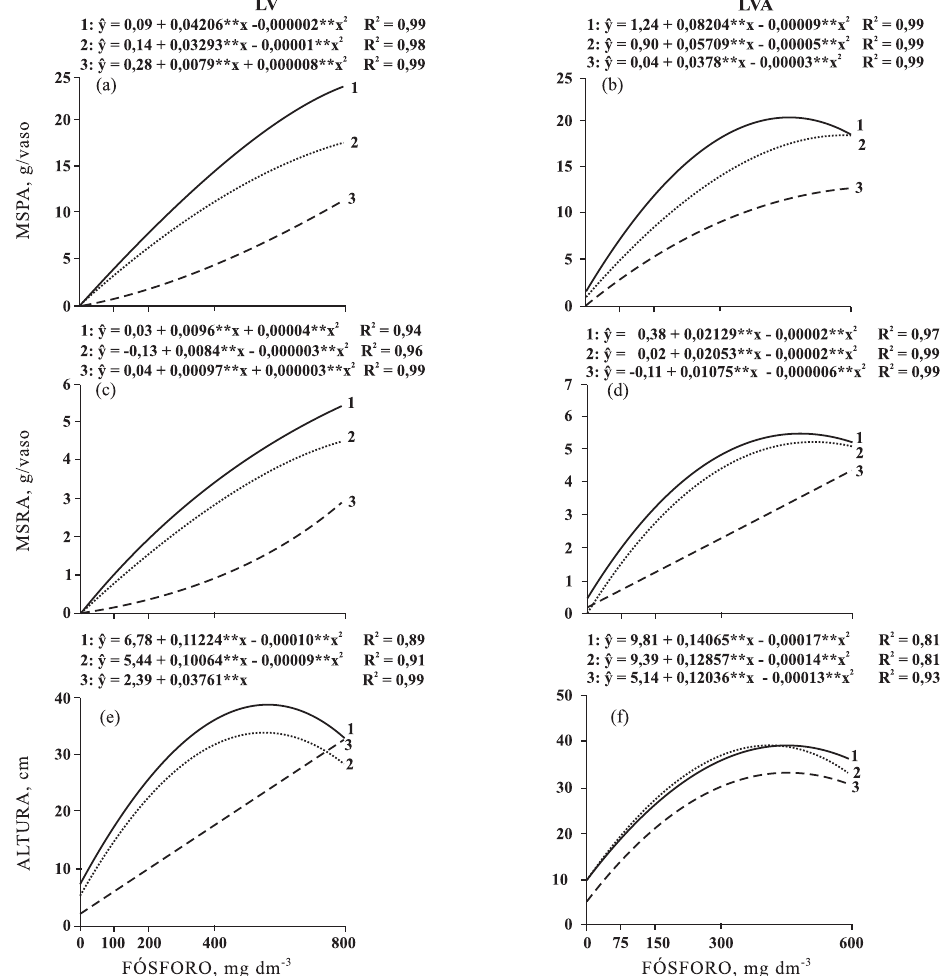
Figura 2. Matéria seca da parte aérea – MSPA - (a, b) e das raízes – MSRA - (c, d) e altura da planta (e, f) do eucalipto cultivado no LV e LVA em função das doses de fósforo, de acordo com cada densidade (LV: 1=0,90, 2=1,10 e 3=1,30 kg dm -3 ; LVA: 1=1,30, 2=1,50 e 3=1,70 kg dm -3 ) (** e *: significativos a 1 e 5 %, respectivamente, pelo teste